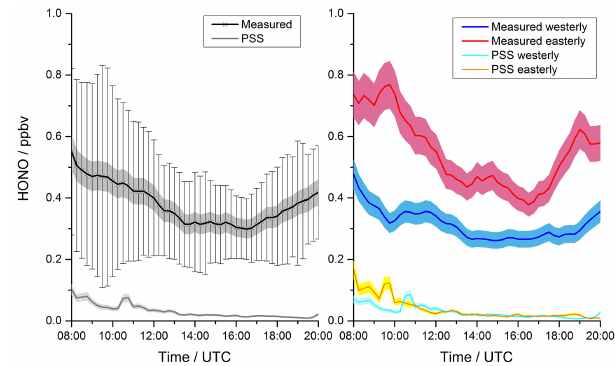
Figure 3. Averaged diurnal profiles (daylight hours) of measured (black) and photostationary state (PSS) calculated (grey) HONO (left panel). The shaded area represents instrumental ( ± 10%) and model ( ± 17%) error; the bars represent the standard deviation of the measurements. The right panel shows averaged diurnal pro- files of measured and PSS HONO divided into easterly (red/orange) and westerly (blue/cyan) conditions. The shaded area represents the measurement ( ± 10%) and PSS ( ± 17%)